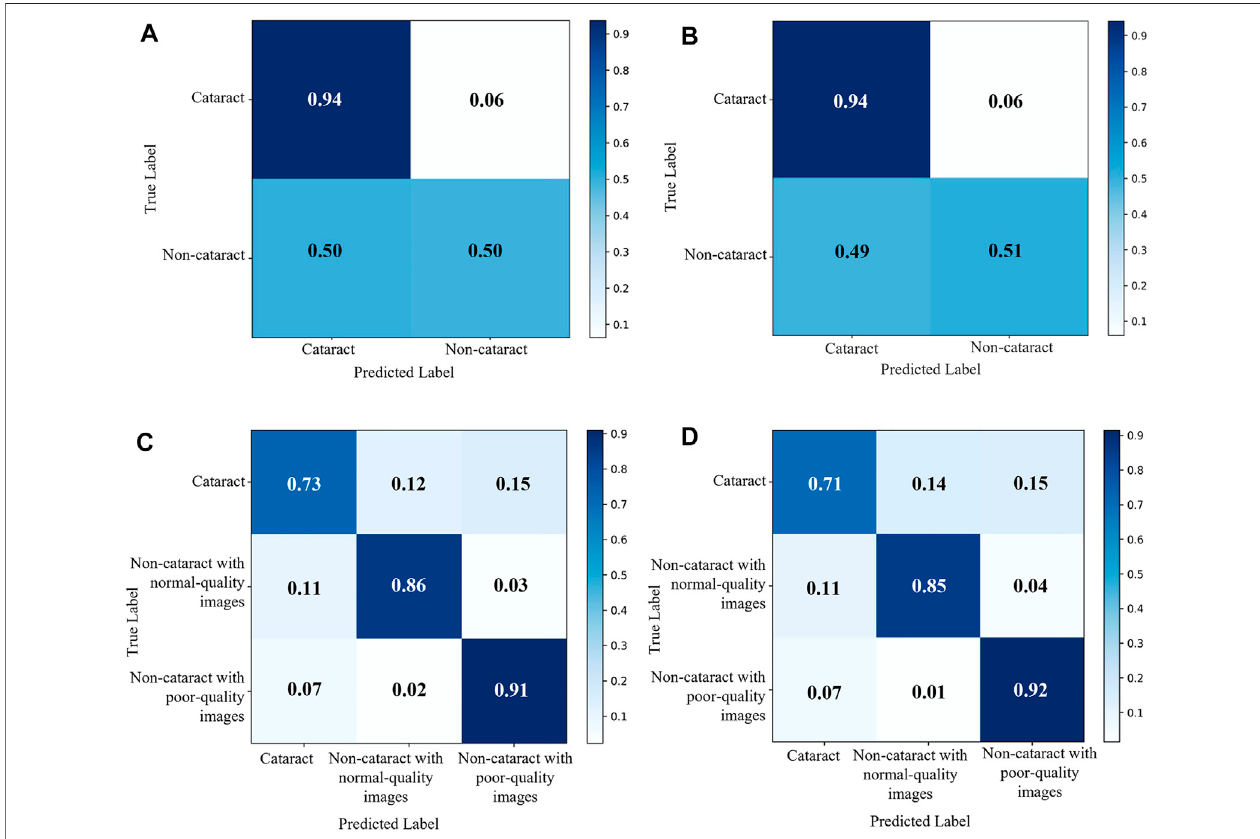
FIGURE 5 | Confusion matrix of the two cataract arti fi cial intelligence diagnosis models. (A) binary-class model in the internal validation dataset. (B) binary-class model in the external test dataset. (C) antiinterference model in the internal validation dataset. (D) Antiinterference model in the external test dataset.